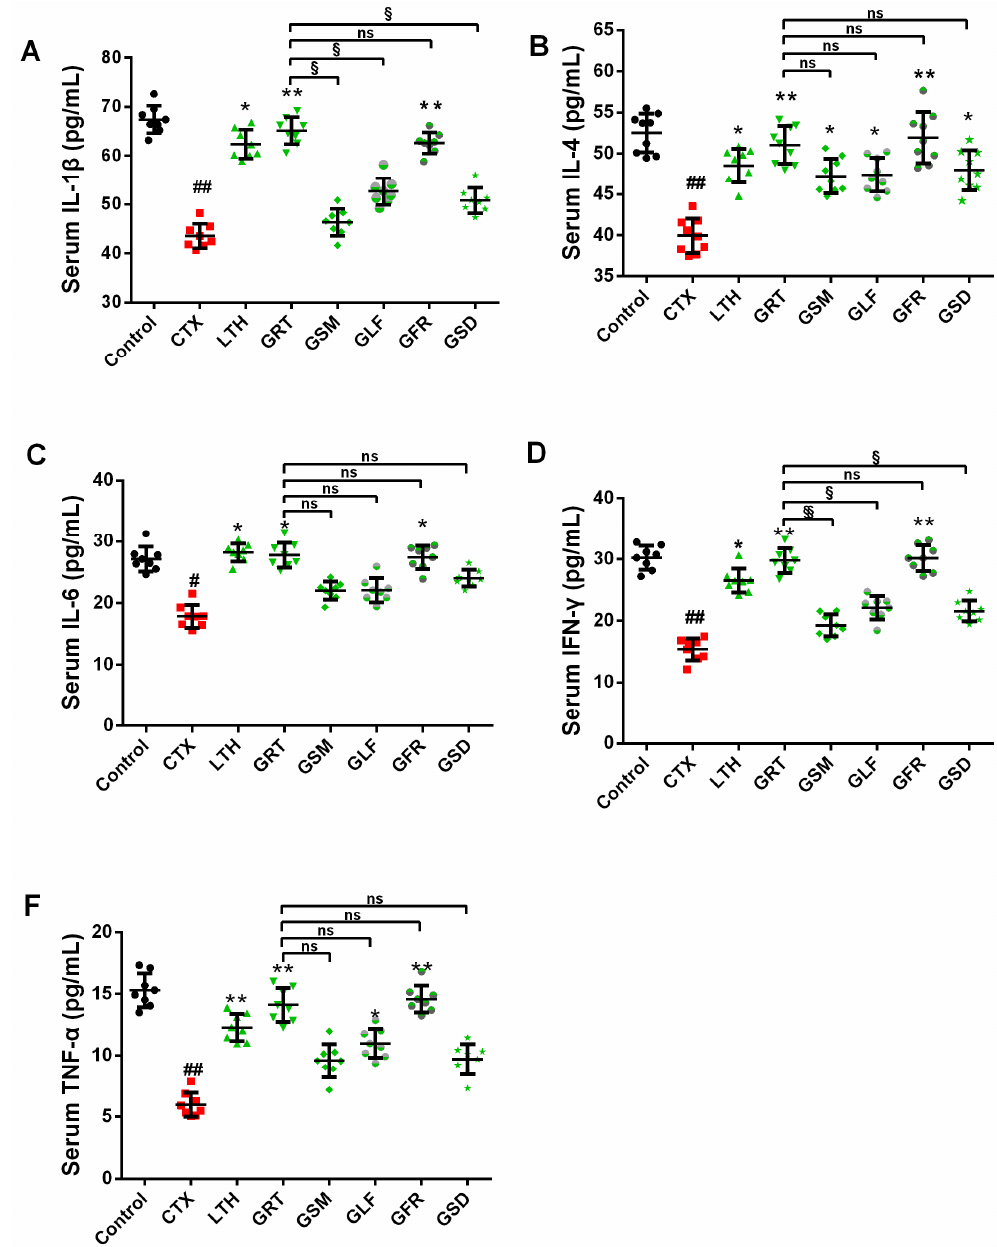
Figure 4. Effect of various parts of ginseng on the serum levels of ( A ) IL-1 β ; ( B ) IL-4; ( C ) IL-6; ( D ) IFN- γ ; ( E ) TNF- α . The values are presented as mean ± SD, n = 10. ## p < 0.01 and # p < 0.05 compared with the control group. ** p < 0.01 and * p < 0.05 compared with the CTX group. §§ p < 0.01, § p < 0.05, ns p > 0.05 compared with the GRT group.